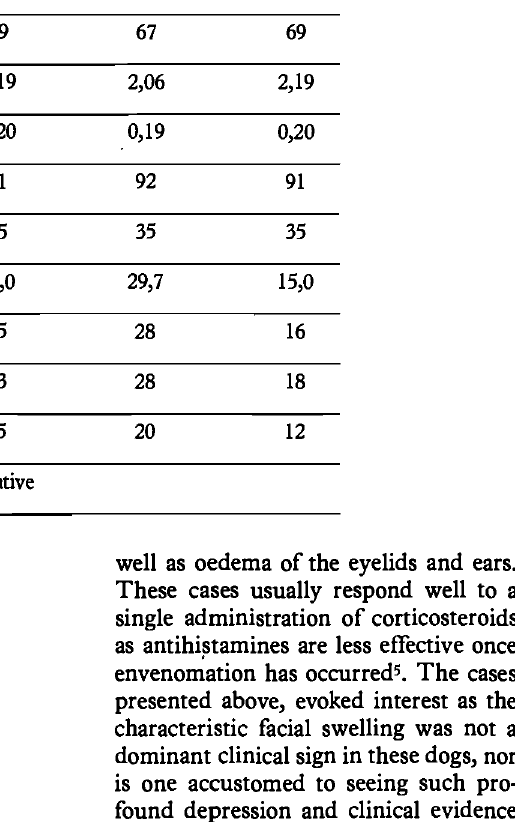
Table 4: Composition of bee venom